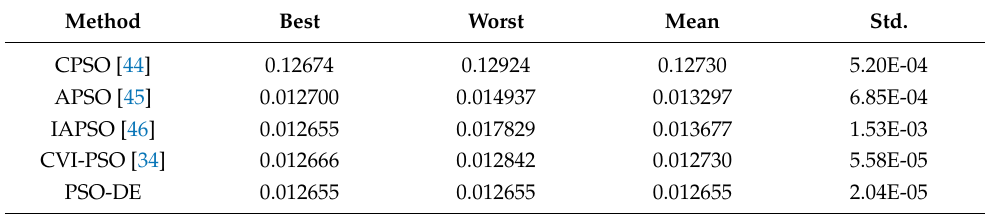
Table 12. Comparison of optimization results of different algorithms for the pressure spring problem. Method